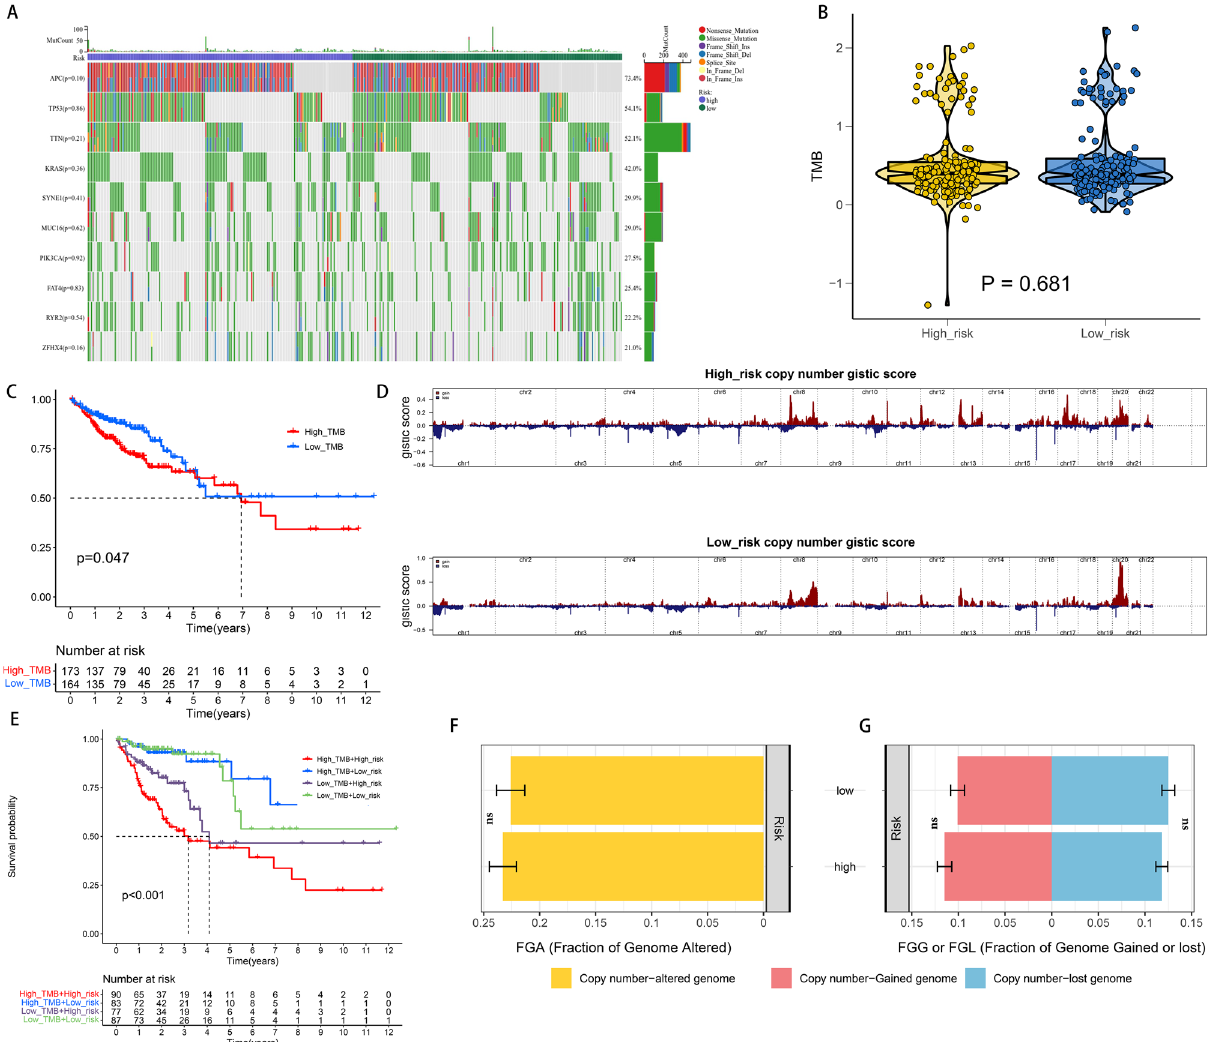
frequency in high-risk and low-risk groups. ( B ) Distribution of TMB in two groups. ( C ) Survival curves for the high ‐ and low ‐ TMB groups. ( D ) Gene fragments profiles with amplification (red) and deletion (blue) among the two groups. ( E ) Survival curves for patients stratified by both TMB and signature. ( F , G ) Comparison of the fraction of the genome altered, lost, and gained between the two